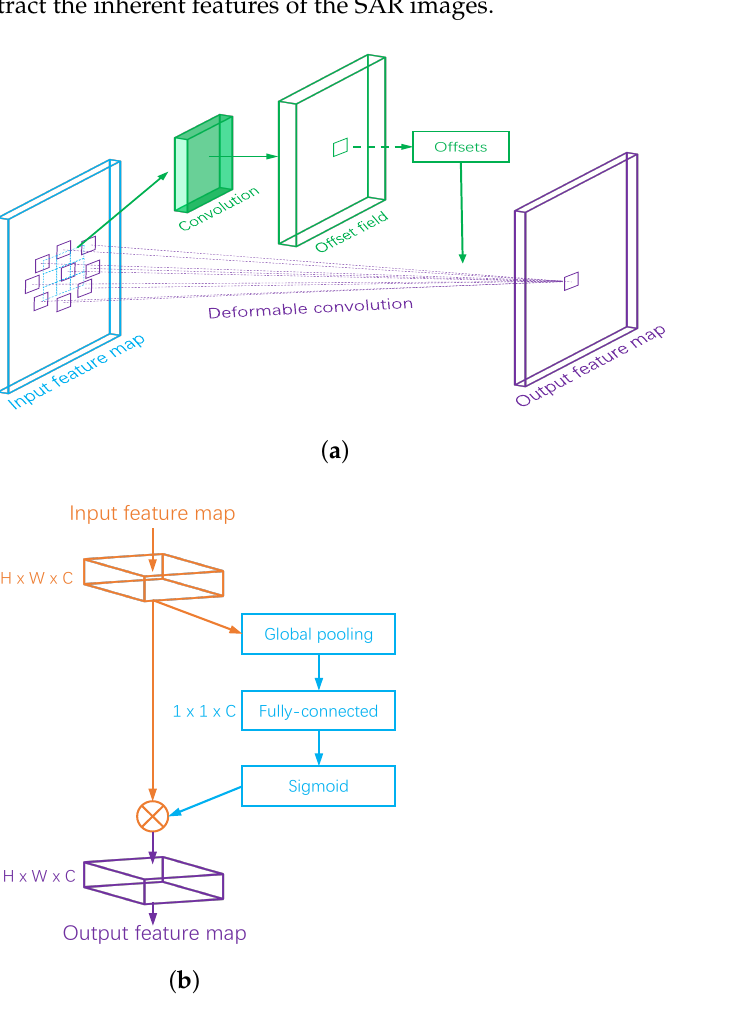
Figure 3. A basic architectural diagram of deformable convolution and SE. ( a ) Deformable convolu- tion. ( b )